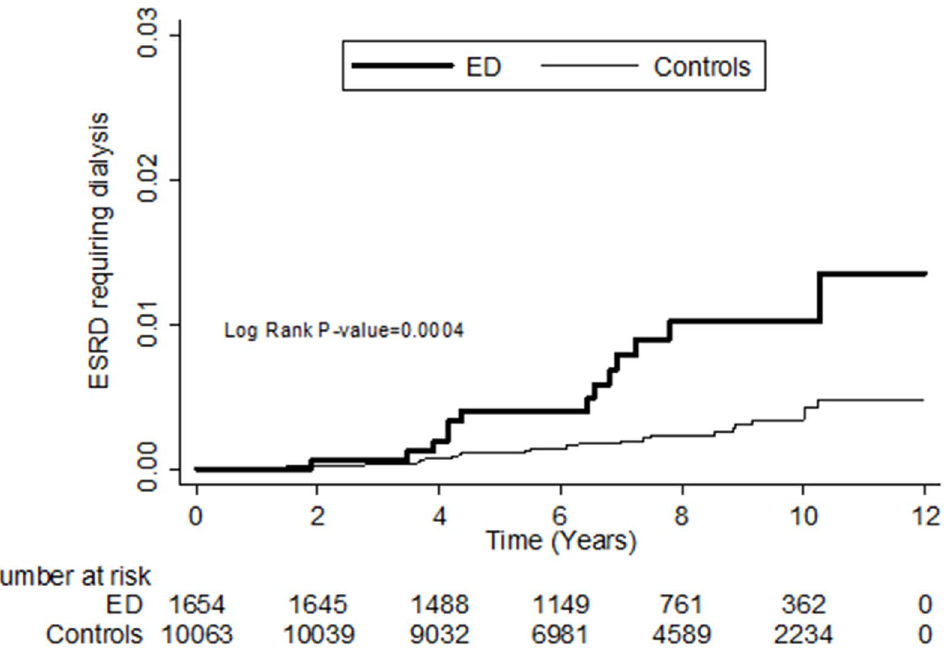
Figure 1. The cumulative incidence rate for end stage renal disease (ESRD) requiring dialysis for patients , 50 years of age with erectile dysfunction (ED) and without ED (log-rank P value =0.0004).